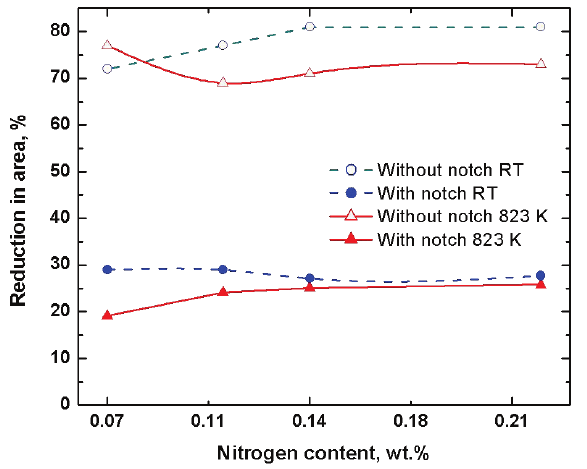
Figure 10. Variations of stresses in the minimum section. Nominal stress 31 MPa (fully elastic condition).